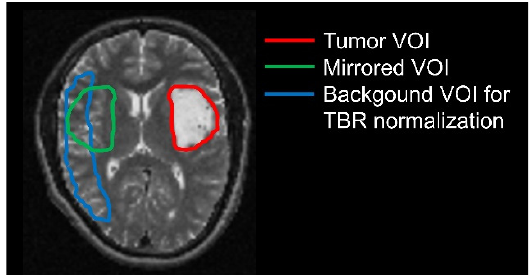
Figure 1. Volumes-of-interest used for analyses of [ 18 ]FET-negative gliomas: tumor VOI defined manually within T2/FLAIR images (red); tumor VOI mirrored to the contralateral site (green); background VOI for image normalization (blue).